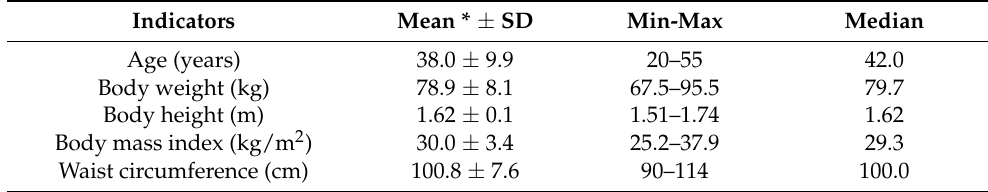
Table 2. Age and anthropometric parameters of the study population ( n = 23).